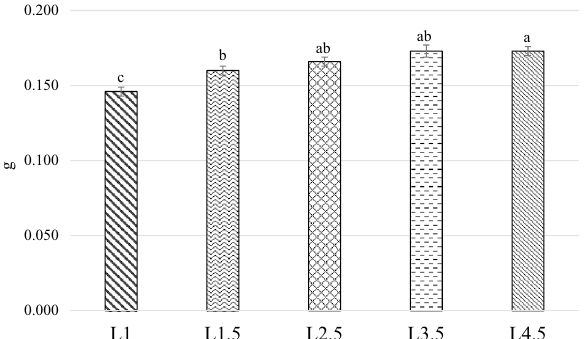
Figure 4. Effect of the diet on the pupae weight. L1 EE 1% diet, L1.5 EE 1.5% diet, L2.5 EE 2.5% diet, L3.5 EE 3.5% diet, L4.5 EE 4.5% diet, GA Gainesville diet, T1 10 day old, T2 14 day old, T3 18 day old. Means with different superscript letters (a, b, c) within the same row differ significantly ( p < 0.05). The standard error is represented by the error bars.